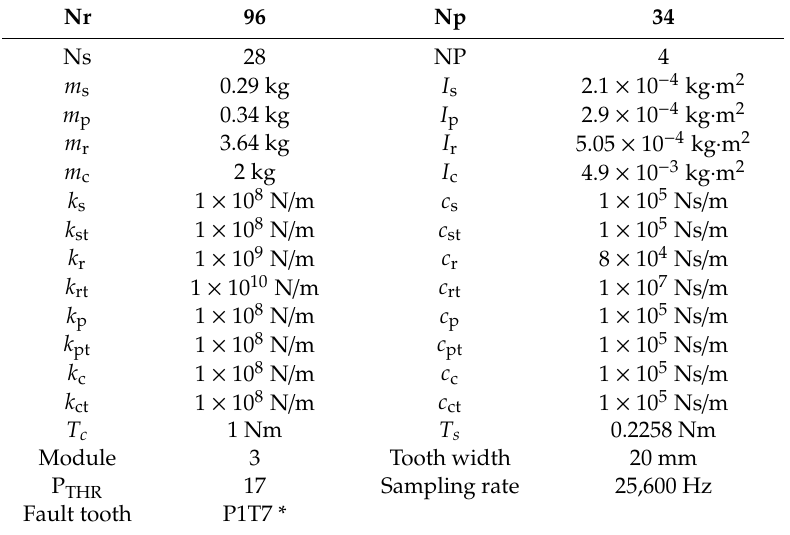
Figure 6. Dynamic simulation signal: ( a ) fault condition and ( b ) health condition. Table 1. Dynamic simulation